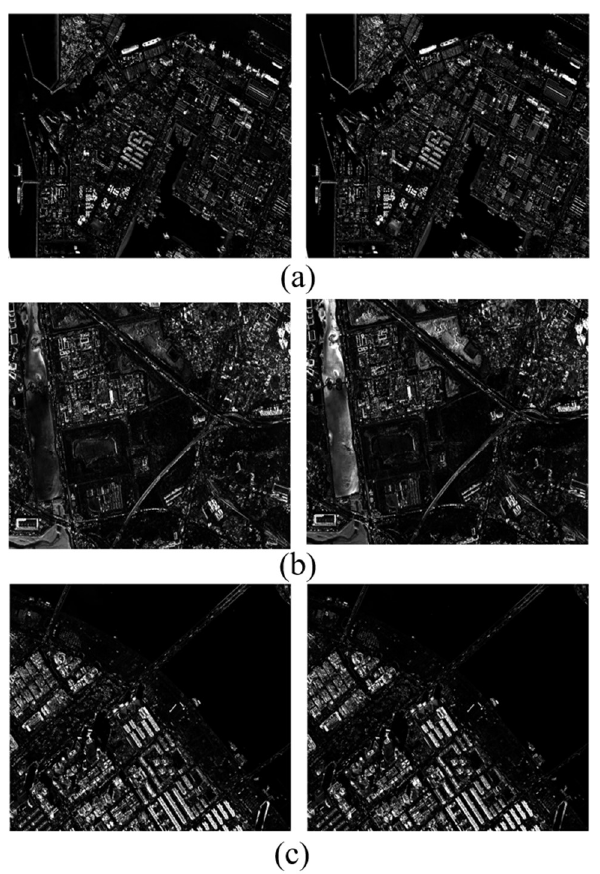
Figure 3. Result of created change magnitude map, Left: MAD, Right: IR-MAD ((a) Incheon 1, (b)Incheon 2, (c) Seoul)